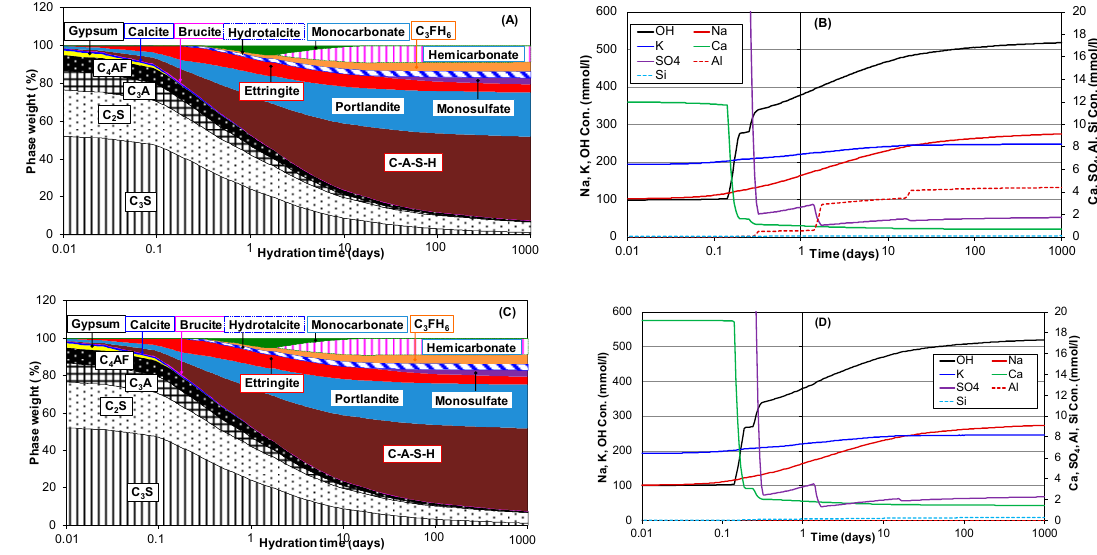
Figure 3. Activity coefficient equation on Portland cement hydration: ( A ) hydrate assemblage and ( B ) pore solution changes from PHREEQC.dat + extended Debye-Huckel equation; ( C ) hydrate assemblage and ( D ) pore solution changes from Pitzer.dat + Pitzer equation for activity coefficient.